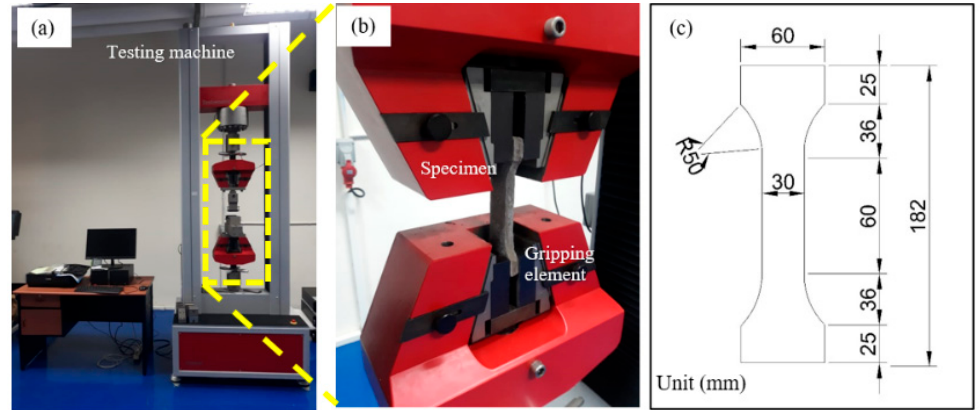
Figure 2. ( a ) Testing machine, ( b ) specimen in gripping element, ( c ) the dimension of typical dog bone specimen.